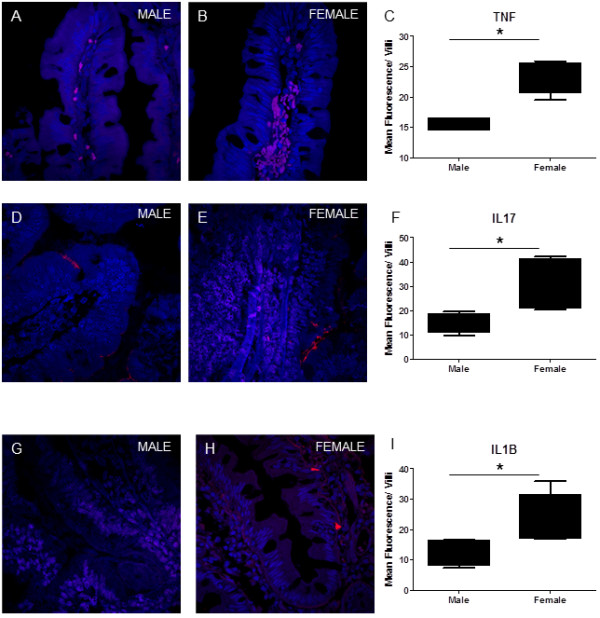
Immunohistochemical analysis of jejunal mucosal samples. Tissue sections were stained for TNFα, IL17 and IL1β. A higher number of cells were observed that were positive for TNFα in women (3B) compared to men (3A). Quatitation for the mean fluorescence intensity of the tissue section showed similar results (3C). Women also had higher levels of IL17 + cells in the villus compared to men (3E vs 3D). On quantitation of mean fluorescence intensity within the villus, women had significantly higher levels compared to men (3F). IL1β staining in the jejunal mucosa in women was higher than in men (3G, H and I). No staining was observed in antibody negative controls. All images were obtained at a 63X magnification. (* = p<.05). Nucleus in blue; Antibody Positive cell in red.